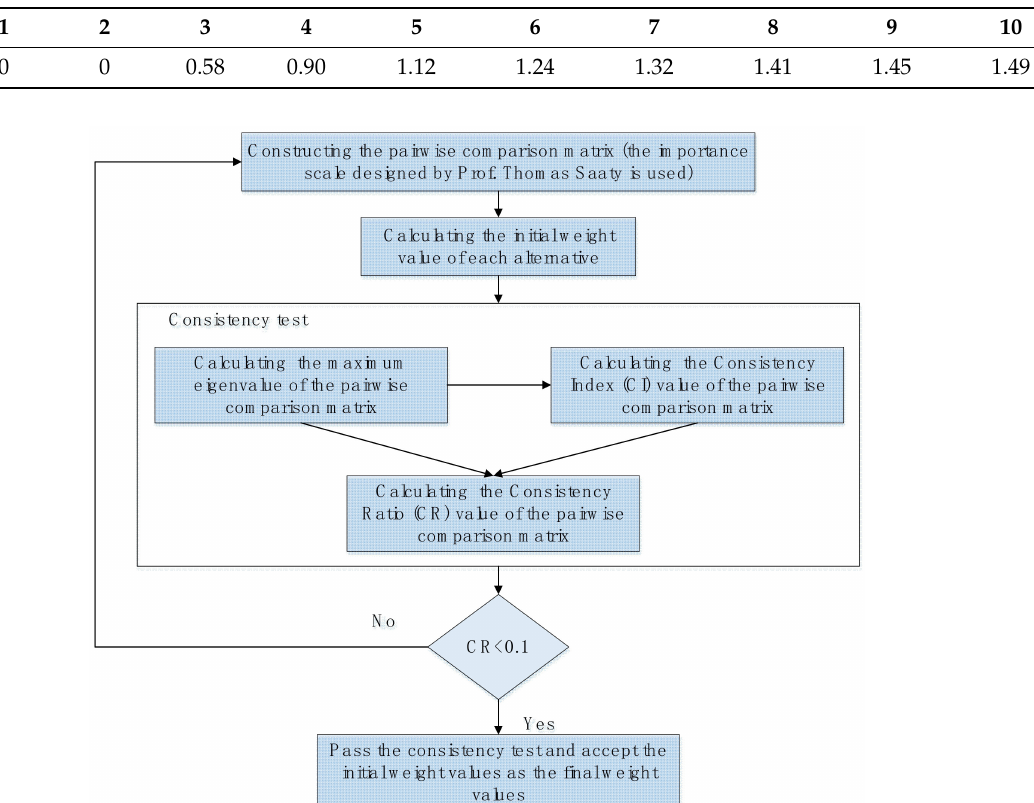
Table 3. The corresponding RI value of each matrix order [37].